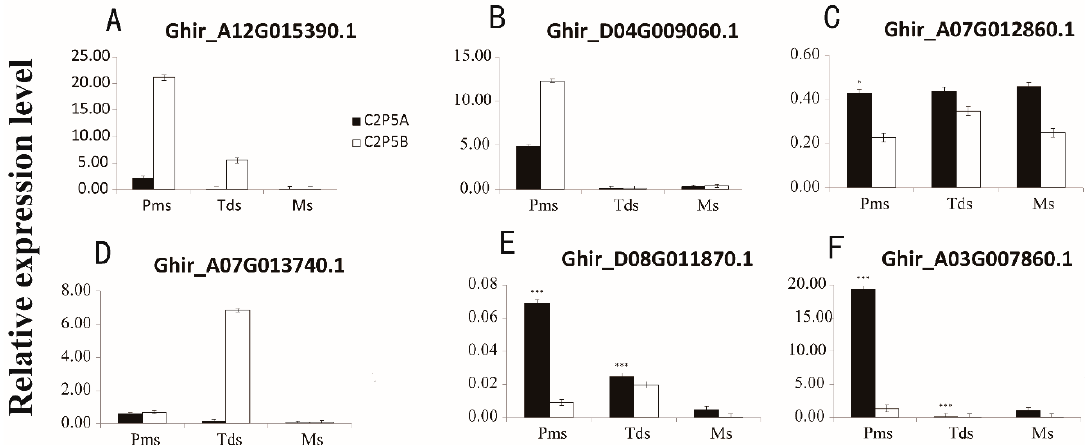
Figure 8. Expression patterns of DEGs in anther development. ( A ), ( B ), ( C ) and ( D ) The ROS detoxification related genes. ( E ) and ( F ) The tapetum development genes. PMs, pollen mother cell stage; Tds, tetrad stage; Ms, mononuclear stage. C2P5A, cytoplasmic male sterile line; C2P5B, maintainer line. The black columns indicate the male sterile line C2P5A, and the white columns indicate the maintainer line C2P5B. The error bars represent SD (Student ′ s t -test), *** p < 0.001, * p < 0.05, and absolute value of log 2 Ratio ≥ 2, p = 0 in ( C ), p = 0 in ( E ), p = 8.57921E − 05 in ( F ), three biological replicates were performed.